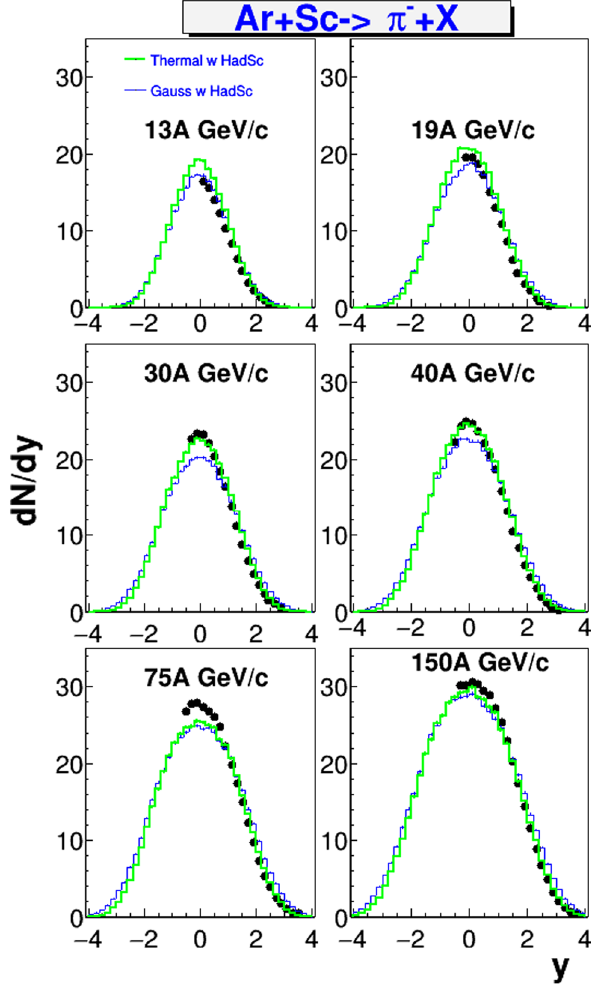
Fig. 8 Rapidity distributions of π − in the 5% most central 40 Ar + 45 Sc collisions at beam momenta of 13A, 19A, 30A, 40A, 75A and 150A GeV/c. The solid and small-dashed lines denote the Gaussian and thermal models, respectively, tuned to pp-parameters of Table 1. The closed points represent NA61/SHINE data [12]